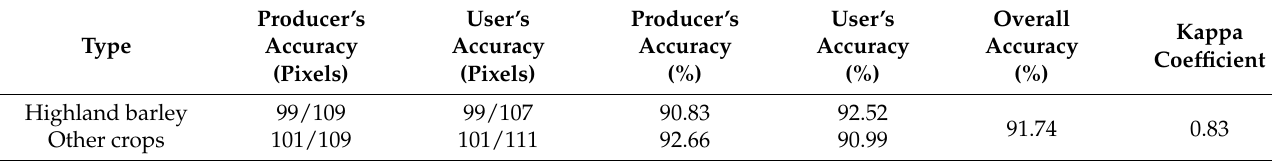
Table 3. Evaluation of the accuracy of Highland barley extraction results.